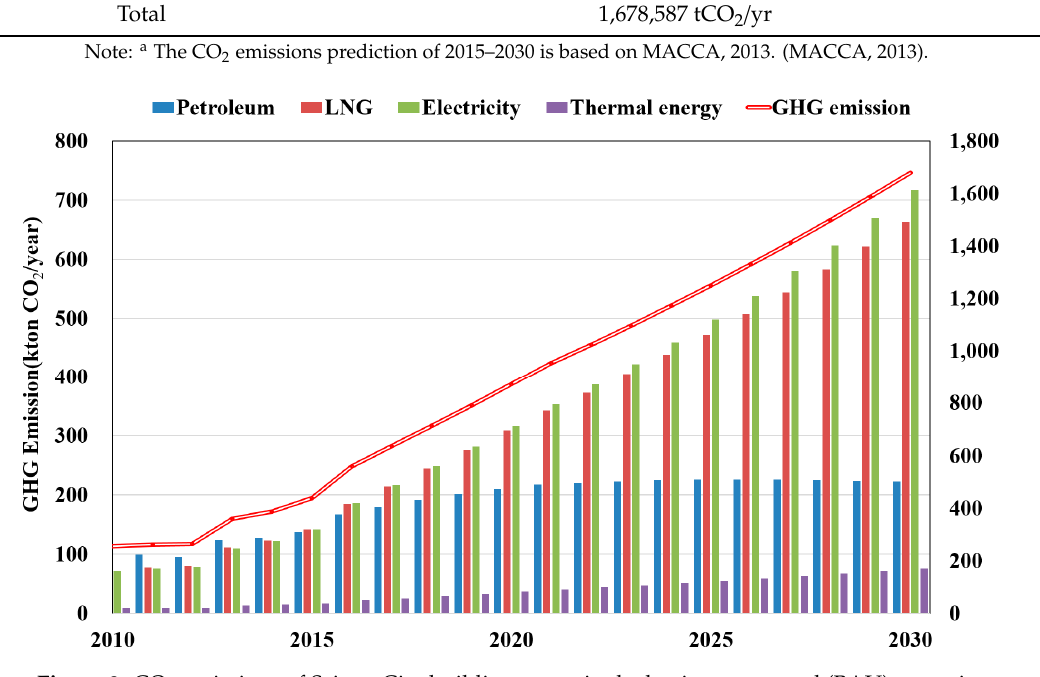
Figure 3. CO 2 emissions of Sejong City building sector in the business-as-usual (BAU) scenario.